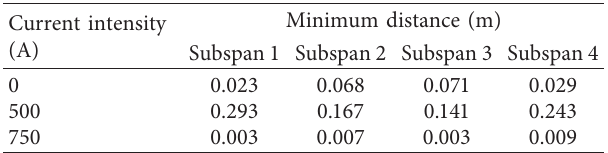
Figure 12: Time histories of distance at the subspan 3 midpoint between two subconductors under different currents ( α � 30 ° ): (a) I � 0A, (b) I � 500A, and (c) I � 750A. Table 5: The minimum distance at each subspan midpoint between two subconductors during the motion process ( α � 30 °